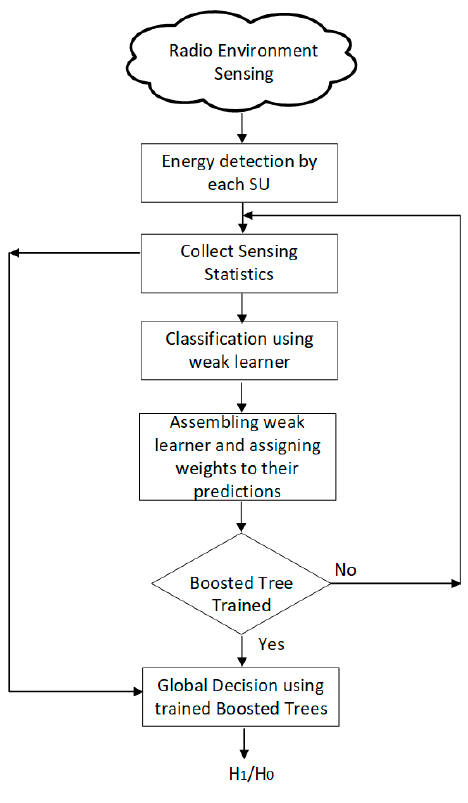
Figure 3. Proposed scheme flowchart.